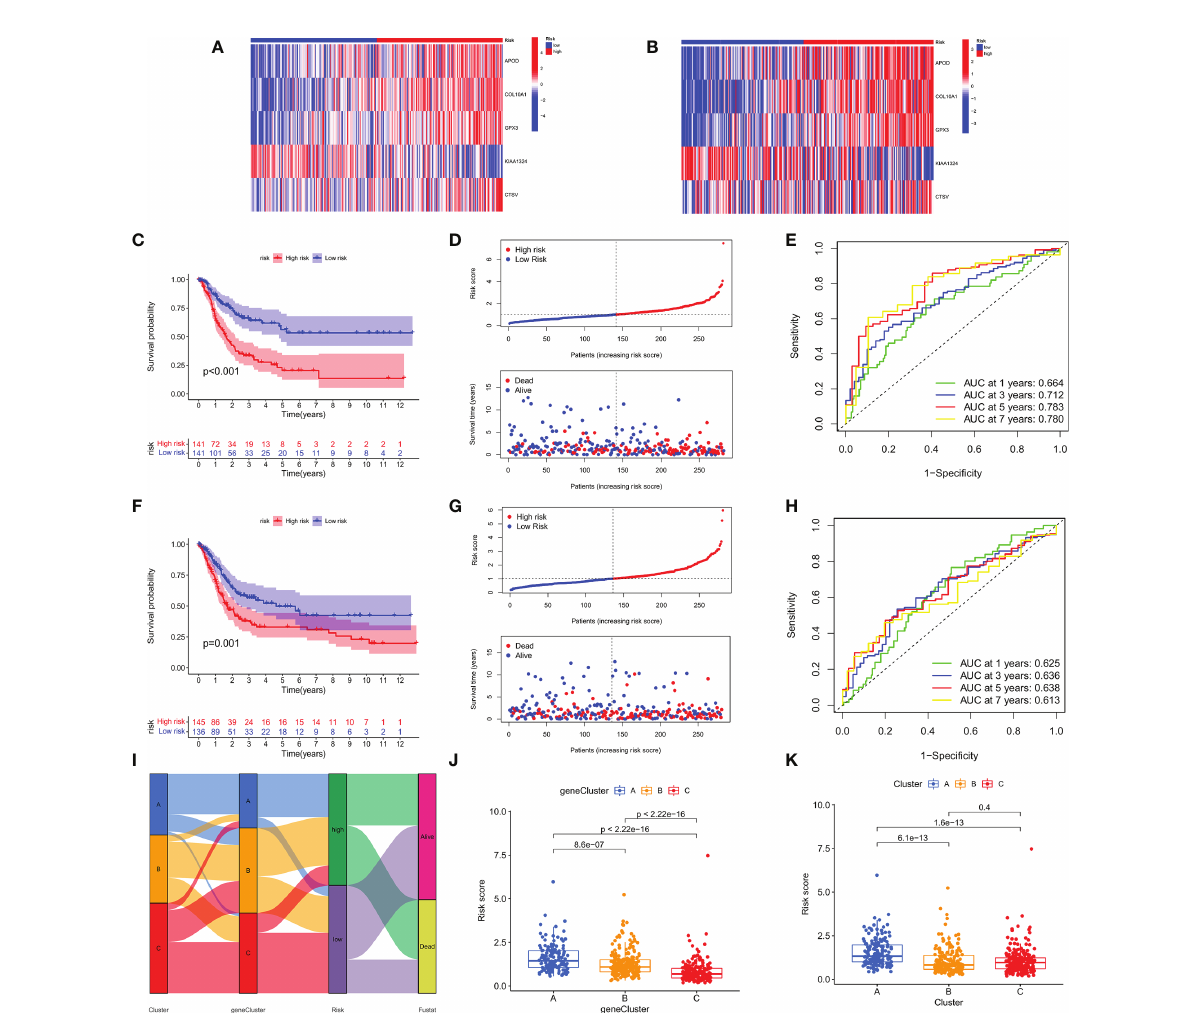
FIGURE 7 Heat map of the expression of the fi ve risk genes in the high- and low- risk groups in Train (A) and Test groups (B) . OS analysis (C) , Risk score distribution and patient survival status (D) , and ROC analysis of predicted 1-, 3-, 5-, and 7-year survival according to m7GRG_score (E) in the Train group. Survival analysis (F) , risk curve (G) and ROC analysis (H) in the Test group. (I) Alluvial diagram of the distribution of patients with different m7G subtypes, genetic subtypes, m7GRG_score and survival outcomes. (J) Differences in m7GRG_score among the three genetic subtypes. (K) Differences in m7GRG_score of the three m7G